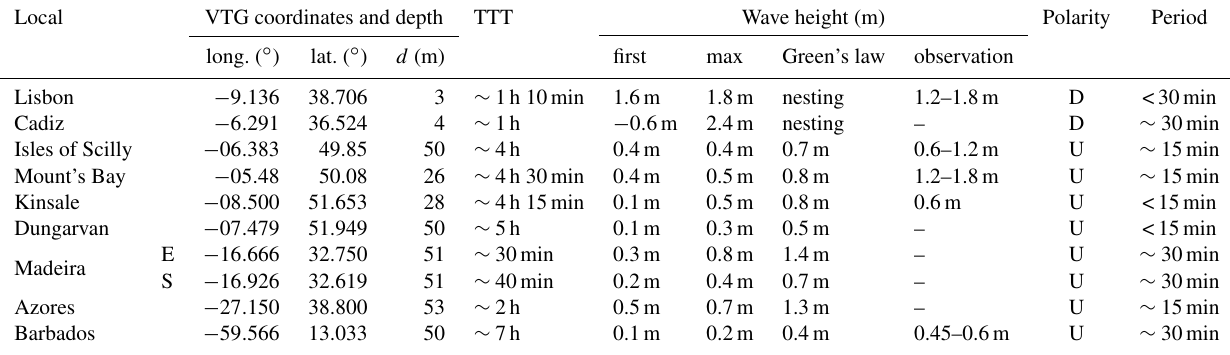
Table 3. Results of the VTGs for hypothesis A-MS. The column TTT lists the observed tsunami travel times. The column polarity indicates the first movement of the sea upward (U) or downward (D). Local VTG coordinates and depth TTT Wave height (m) Polarity Period long. ( ◦ ) lat. ( ◦ ) d (m) first max Green’s law